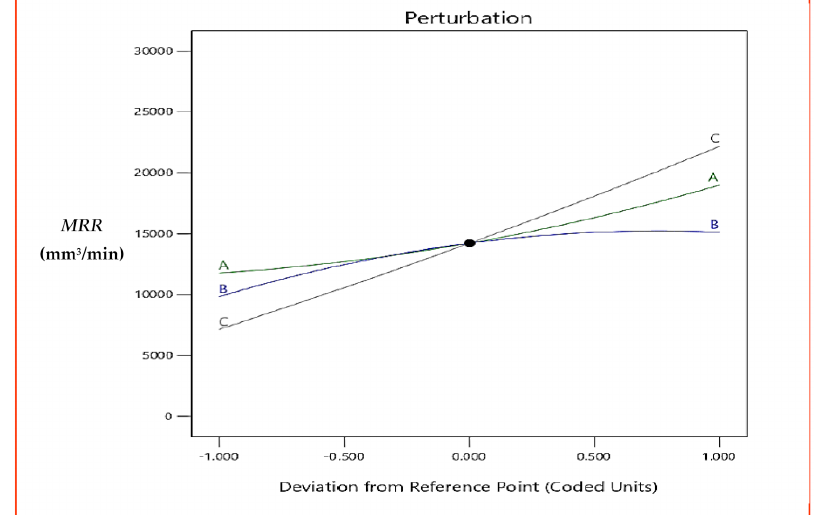
Figure 6. Response graph for MRR .